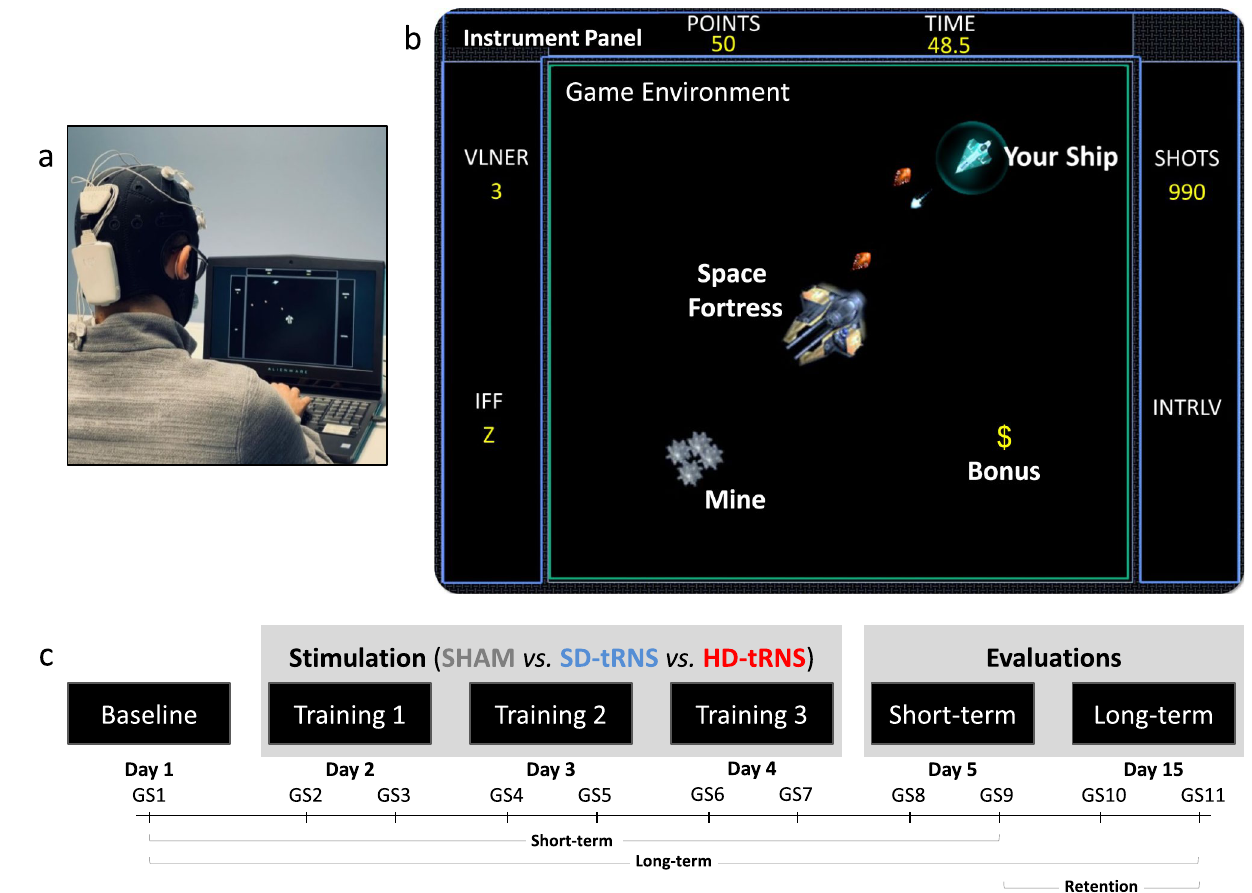
Figure 1. Experimental design and performance evaluation. ( a ) A participant playing the Space Fortress game (in this example, the participant is equipped with a 4 × 1 HD montage). ( b ) Space Fortress in-game screenshot. ( c ) Timeline of the experimental protocol. GS n stands for Game Session number n across days. Short-term is the delta of performance between GS9 and GS1. Long-term is the delta of performance between GS11 and GS1. Retention is the delta of performance between GS11 and